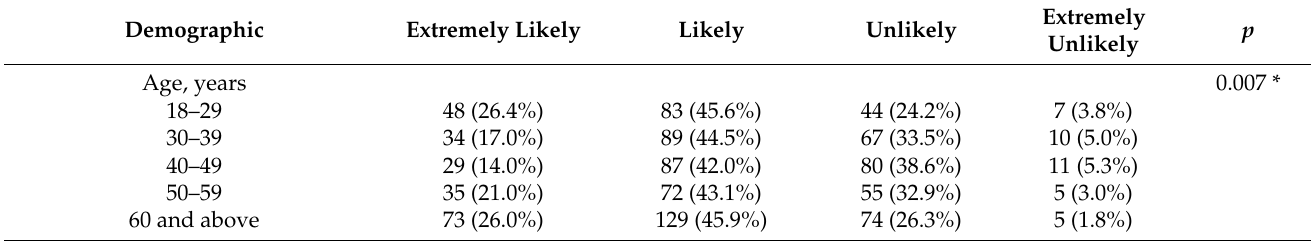
Table 2. Willingness to be vaccinated against COVID-19 by demographics of the participants in Japan ( N =